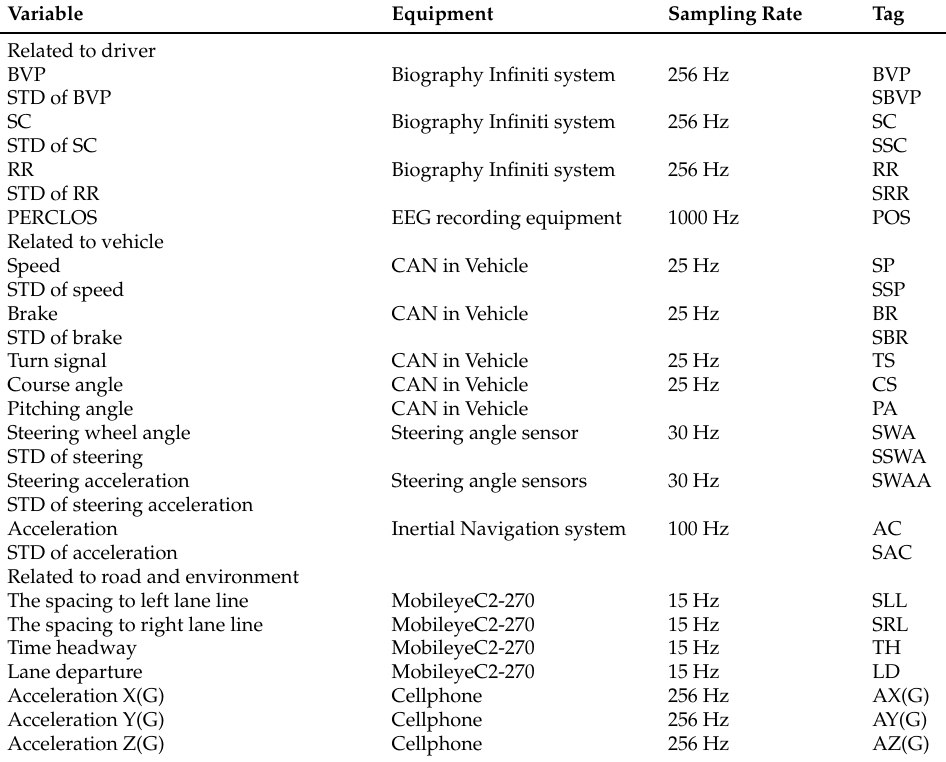
Figure 4. Installation of the data collection system. Table 1. The characteristics of the collected data.